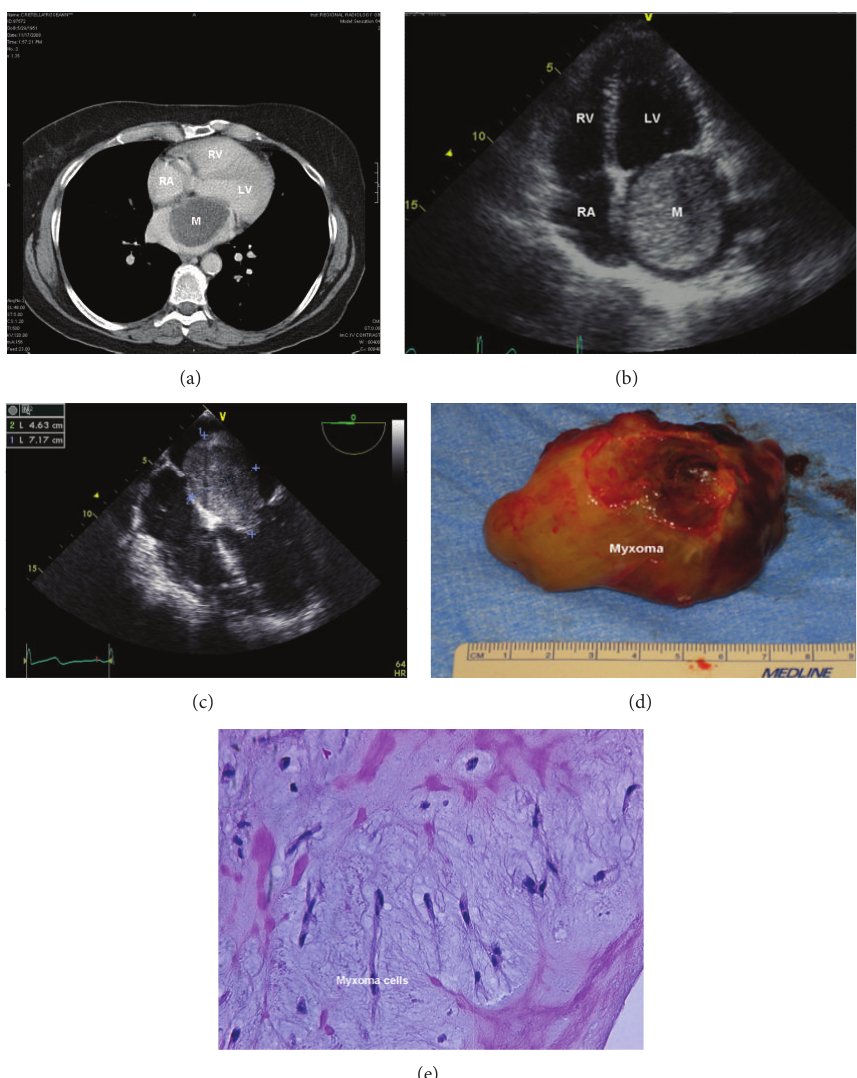
Figure 1: (a) Computed tomographic scan revealing a large hypodense mass (+ 30 Hounsfield units) in the left atrium. (b) Transthoracic echocardiogram (apical 4-chamber view) showing a giant, solid, smooth mass in left atrium, attached to the interatrial septum causing severe obstruction of the mitral valve in diastole. (c) Intraoperative transesophageal echocardiogram confirming the attachment of the left atrial mass (7.17 × 4.63 cm) to the interatrial septum. (d) Resected tumor (7.7 × 5.5 × 3.7 cm) having a nodular hemorrhagic surface and mucoid glistening variegated cut surface with focal hemorrhage. (e) Microscopic examination (H&E stain) showing abundant myxoid stroma and scattered polygonal cells with scanty cytoplasm typical of myxoma. Myxoma cells forming rings, cords, and nests around the capillaries with positive immunoreactivity to